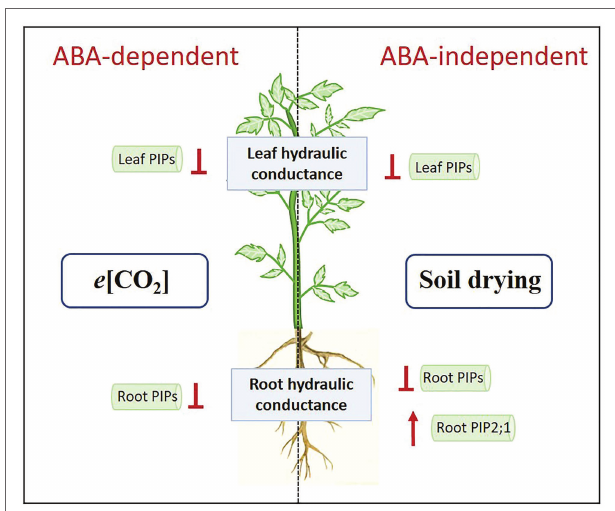
FIGURE 9 | Hypothetical model of regulation of elevated CO 2 ( e [CO 2 ]) and severe drought stress on plant water relations. Results of the present study indicate that e [CO 2 ] could downregulate PIP s in leaves and roots, thus decreasing leaf and root hydraulic conductance, which was ABA-dependent. Meanwhile, severe drought stress could downregulate PIP s in leaves, which might be correlated with dramatic decrease in leaf hydraulic conductance. In roots, the regulation of PIP s by drought stress were varied: most of PIP s were downregulated; PIP2;1 was upregulated. Those effects of drought stress were ABA-independent. When drought stress became severe, the effects of severe drought on plant hydraulic conductance could override those of e [CO 2